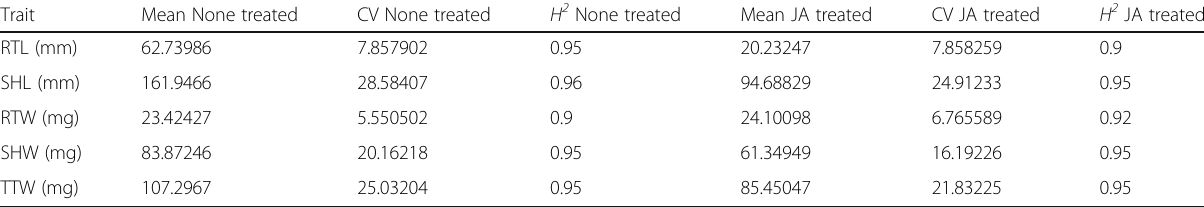
Table 1 phenotypic variation and broad sense heritability for each trait Trait Mean None